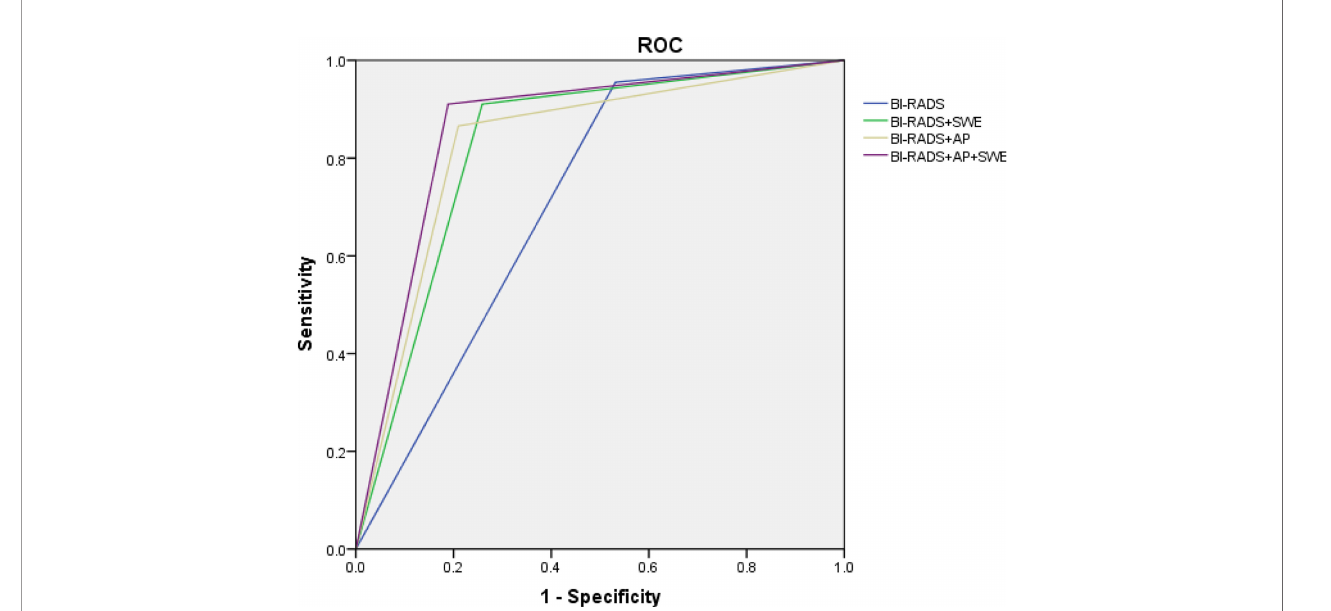
FIGURE 4 | ROC of Breast Imaging Reporting and Data System alone and combined qualitative shear wave elastography and/or AngioPLUS microvascular Doppler ultrasound technique. ROC, receiver operating characteristic; AUC, area under the ROC curve.